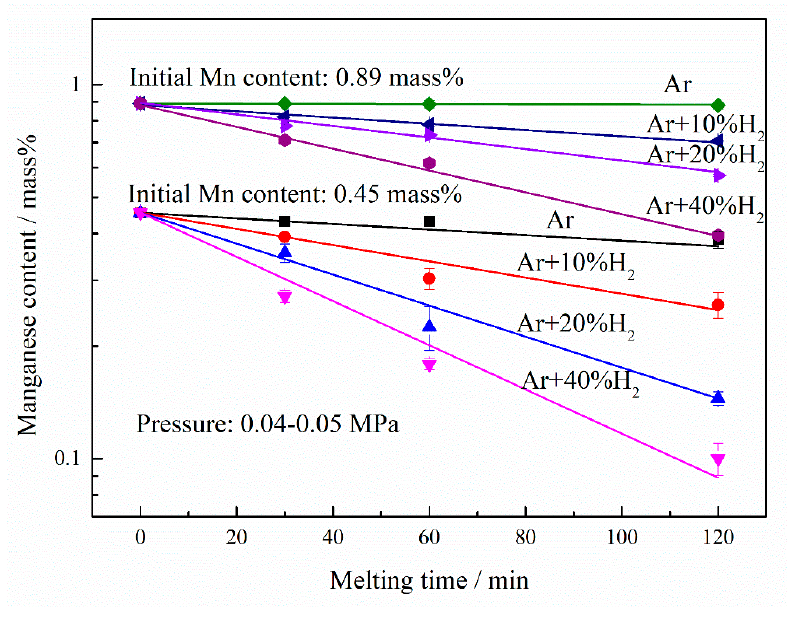
Figure 5. Change in the manganese content of liquid nickel during HPAM with different initial manganese contents (0.89 mass% and 0.45 mass%).